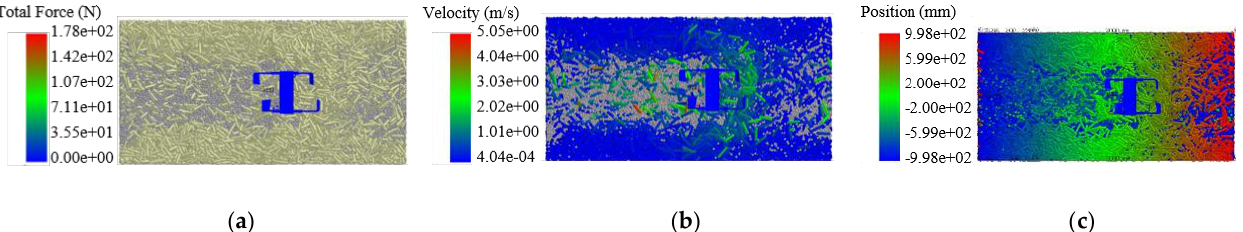
Figure 6. Simulation diagrams of the opposite-placed anti-blocking mechanism. ( a ) The force of the anti-blocking mechanism afforded; ( b ) Straw movement; ( c ) Straw displacement.